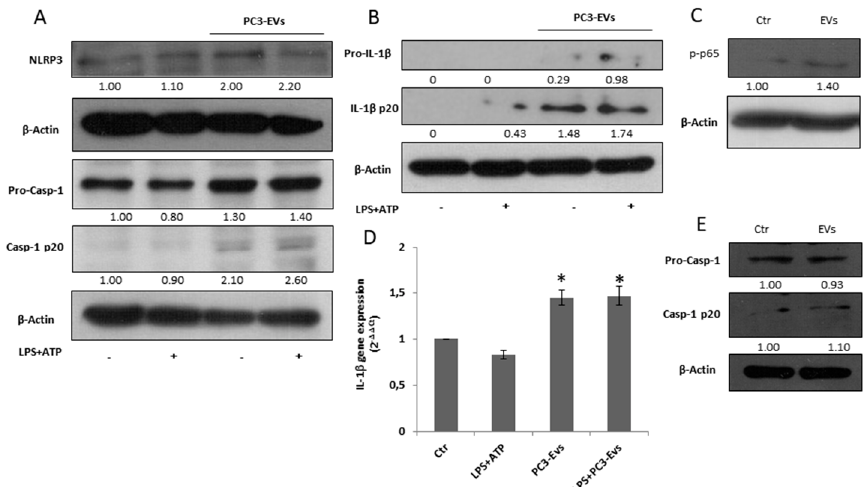
Figure 3. PC3-derived EVs induce caspase-1 activation and IL-1 β maturation in PNT2 cells.PNT2 cells were treated with 100 µg/mL of PC3-derived EVs (PC3-EVs) either in the presence or in the absence of 10 µg/mL LPS + 5 mM ATP (LPS + ATP). After a 24 h exposure, ( A ) NLRP3, caspase-1 full length and mature caspase-1-p20 expression and ( B ) pro-IL-1 β full length and mature IL-1 β -p20 expression were evaluated in total extract analyzed by Western blotting. β -actin was used as a loading control. The images are representative of one out of at least three separate experiments. ( C ) After a 3 h exposure, p-NF- κ B (p65) expression was evaluated in total extract and analyzed by Western blotting. β -actin was used as a loading control. The images are representative of one out of at least three separate experiments. ( D ) qRT-PCR of IL-1 β gene after a 6 h exposure. Gene expression values were normalized to HPRT and presented as 2 −ΔΔ Ct . Relative mRNA gene abundance in PNT2 cells was assumed as 1 (Ctr). Data represent mean ± SD ( n = 5). * p < 0.05 vs. PNT2 cells. ( E ) PNT2 cells were treated with 100 µg/mL of PNT2-derived EVs (PNT2-EVs) for 24 h and caspase-1 full length and mature caspase-1-p20 expression was evaluated in total extract analyzed by Western blotting. β -actin was used as a loading control. The images are representative of one out of n = 5 separate experiments. Numbers below the images represent the ratio between the respective protein and β -actin band intensity.